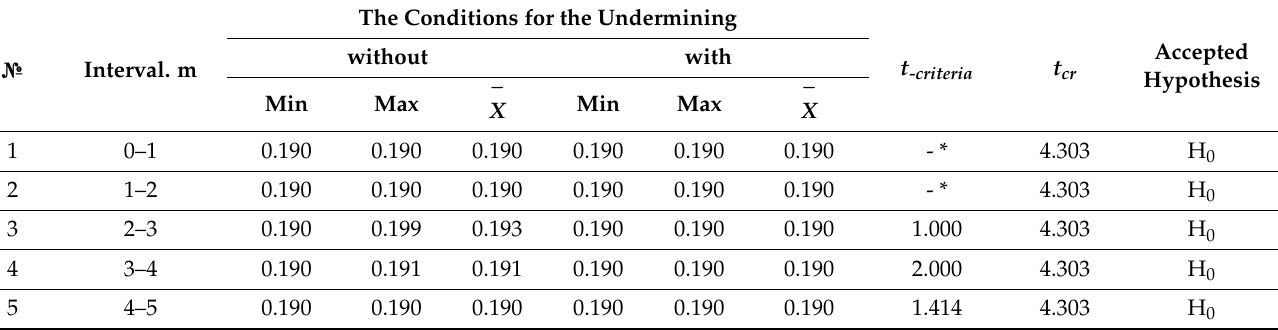
Table 10. The results of the statistical analysis of the experimental studies of the free gas pressure of the drift